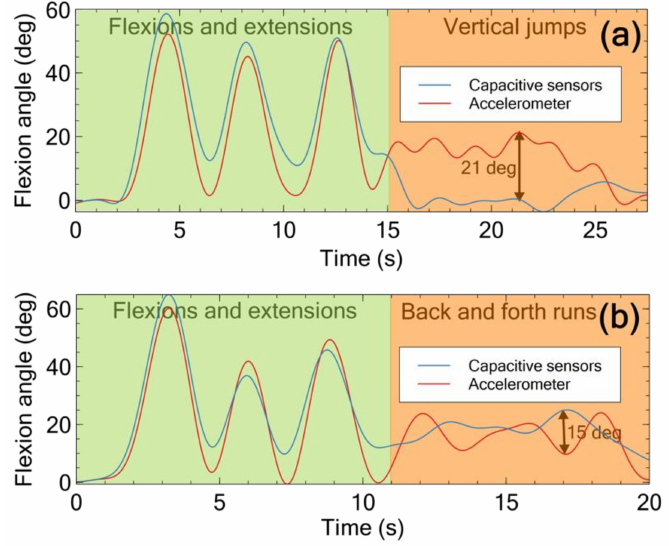
Figure 8. Signals obtained from those presented in the previous figure, following a low-pass digital ideal filtering with a cut-off frequency of 0.5 Hz: ( a ) vertical jumps in place; ( b ) back and forth